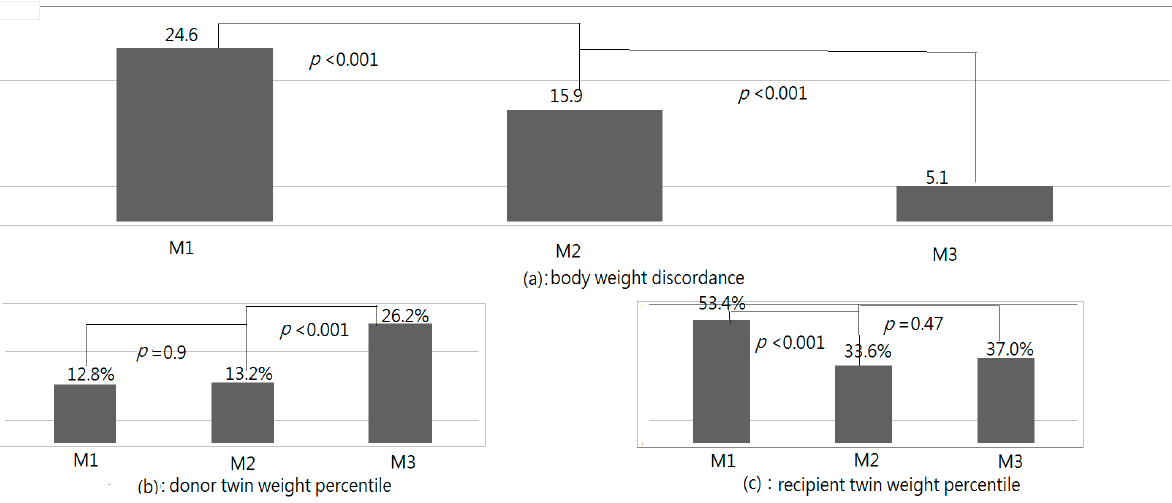
Figure 2. Body weight discordances (BWDs) and weight percentiles of donor and recipient fetuses (Table 1) upon birth (M2), and at neonatal follow-up